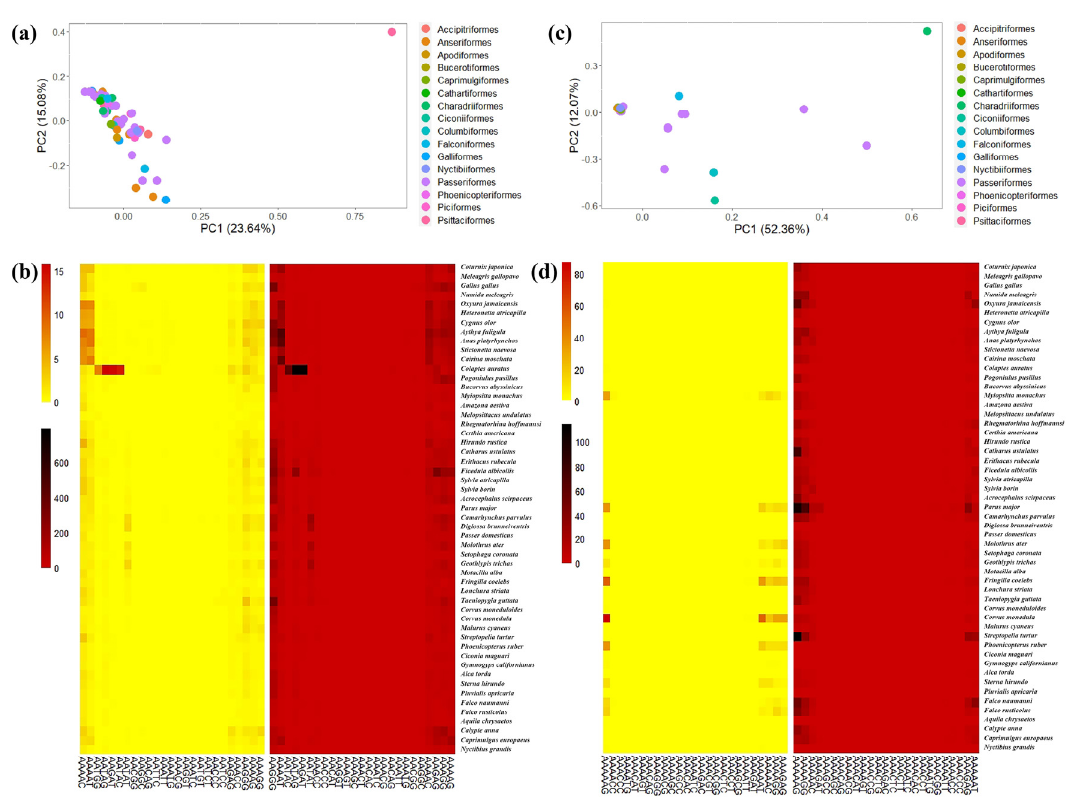
Figure 4. Phylogenetic PCA, loci/Mb heatmaps and bp/Mb heatmaps for di- ( a , b ), tri- ( c , d ), and tetranucleotide ( e , f ) P-SSR motifs. For all heatmaps, the yellow section represents the abundance (loci/Mb) of different motifs and the red section represents the density (bp/Mb) of each motif.